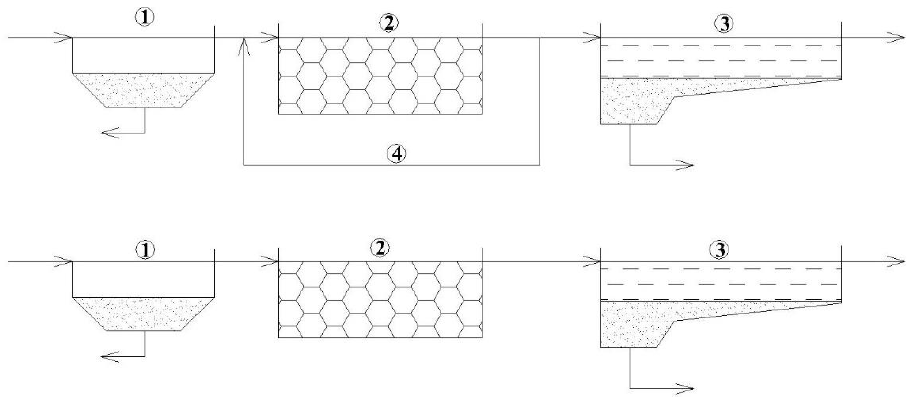
Figure 3. Trickling filters schemes: 1 — PC; 2 — TF; 3 — SC; 4 — recycle flow (RF).